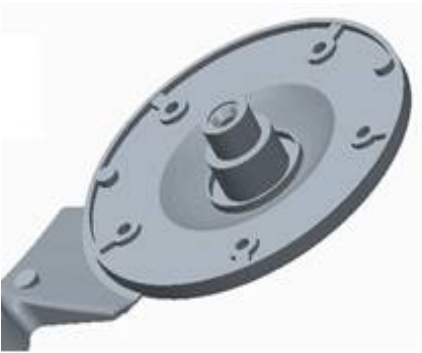
Figure 5. The melt jet is outside the core. Figure 6. The melt jet is directed right towards the